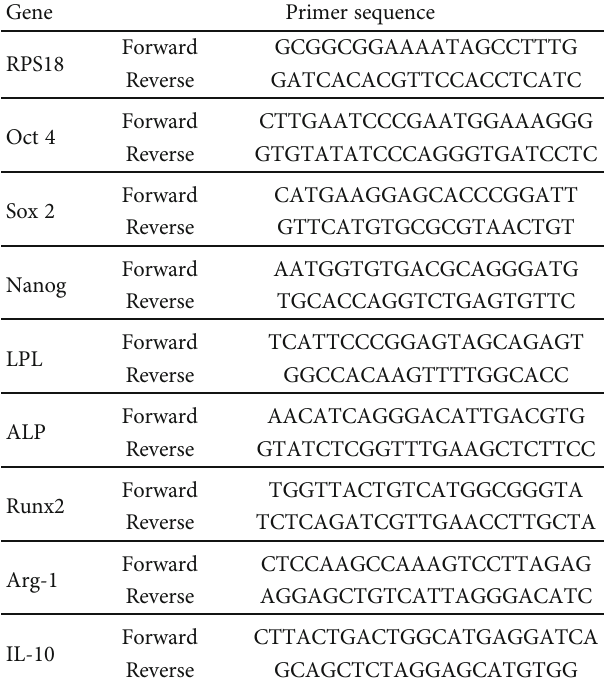
Table 1: Primers used in real-time polymerase chain reaction gene expression